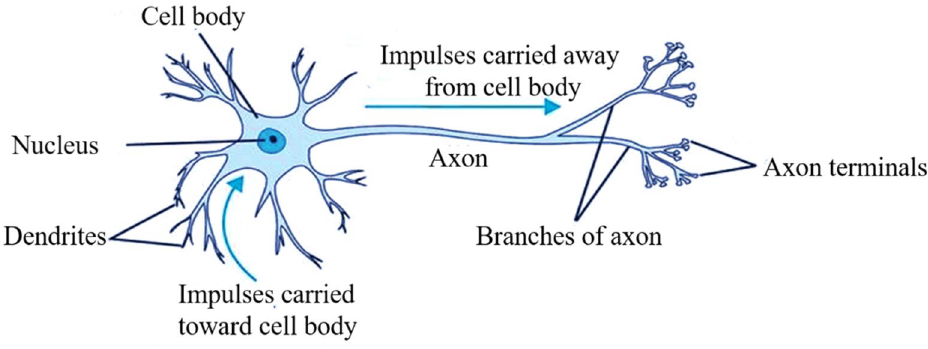
Figure 9. Schematic diagram of biological neurons.